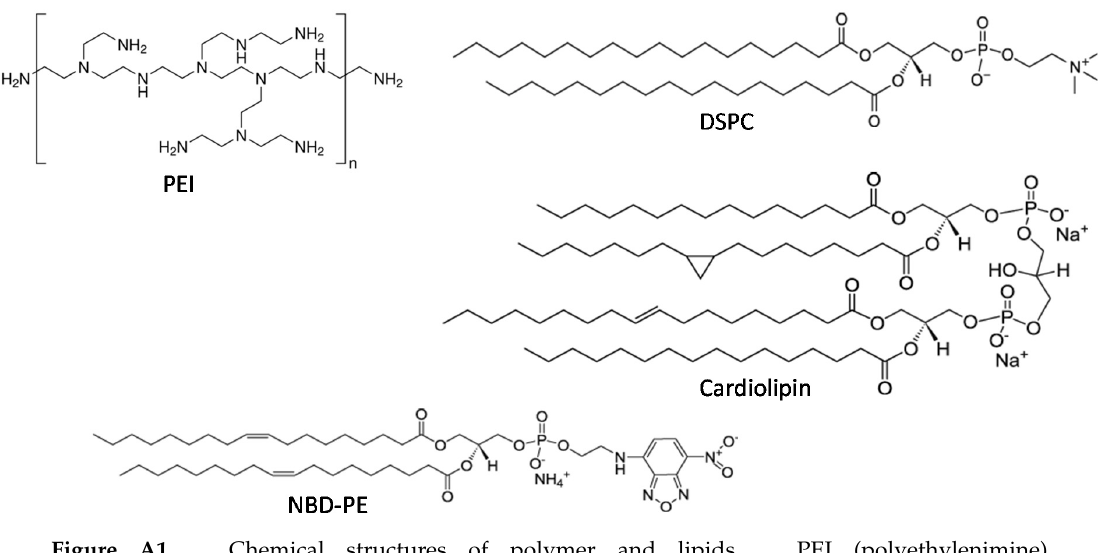
Figure A1. Chemical structures of polymer and lipids. PEI (polyethylenimine), DSPC (1,2-distearoyl- sn-glycero-3-phosphocholine), NBD-PE (1,2-dioleoyl-sn-glycero-3-phosphoethanolamine-N-(7-nitro- 2-1,3-benzoxadiazol-4-yl) (ammonium salt)).